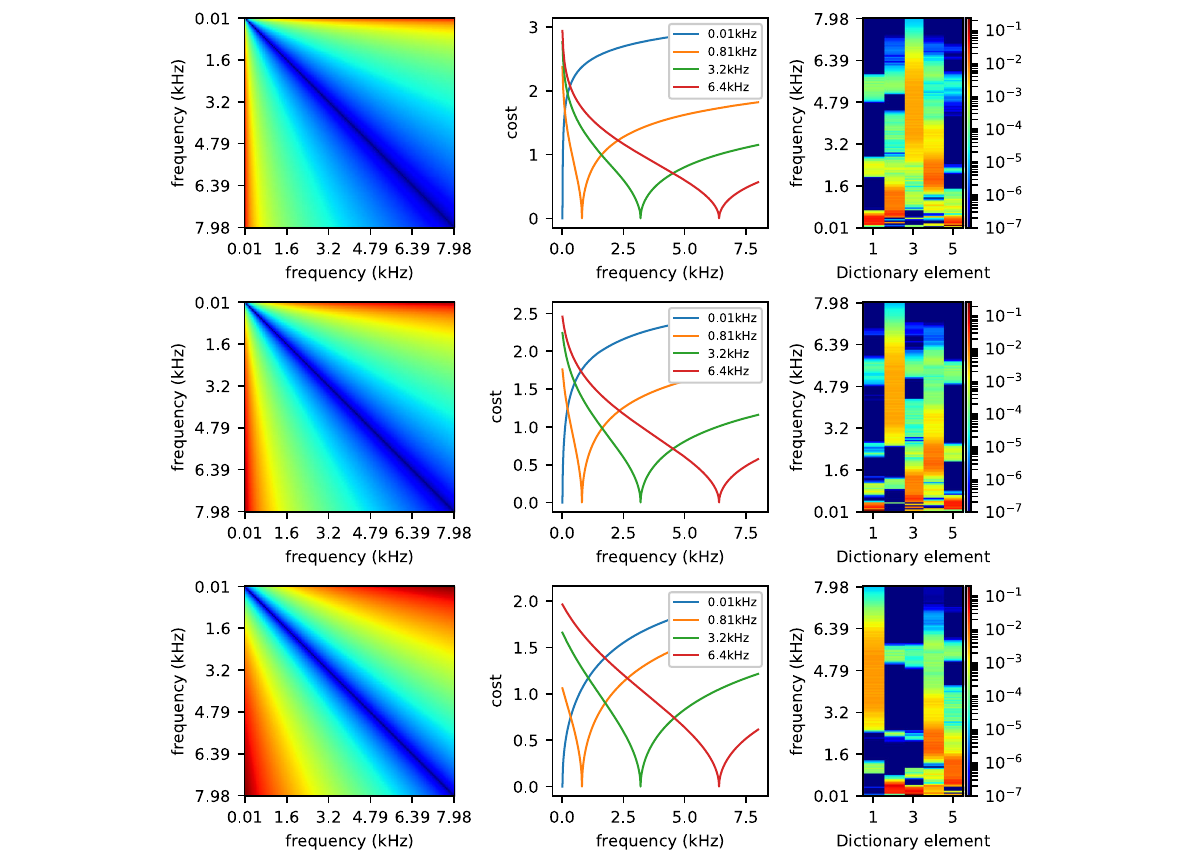
Fig. 2 Influence of parameter λ of the cost matrix. Left, cost matrix; center, sample lines of the cost matrix; right, dictionary learned on the validation data. Top, λ = 1; center, λ = 100; bottom, λ =